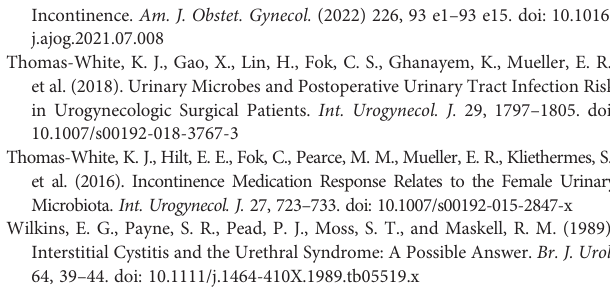
Supplemental Table 2 | Correlation of participant characteristics with